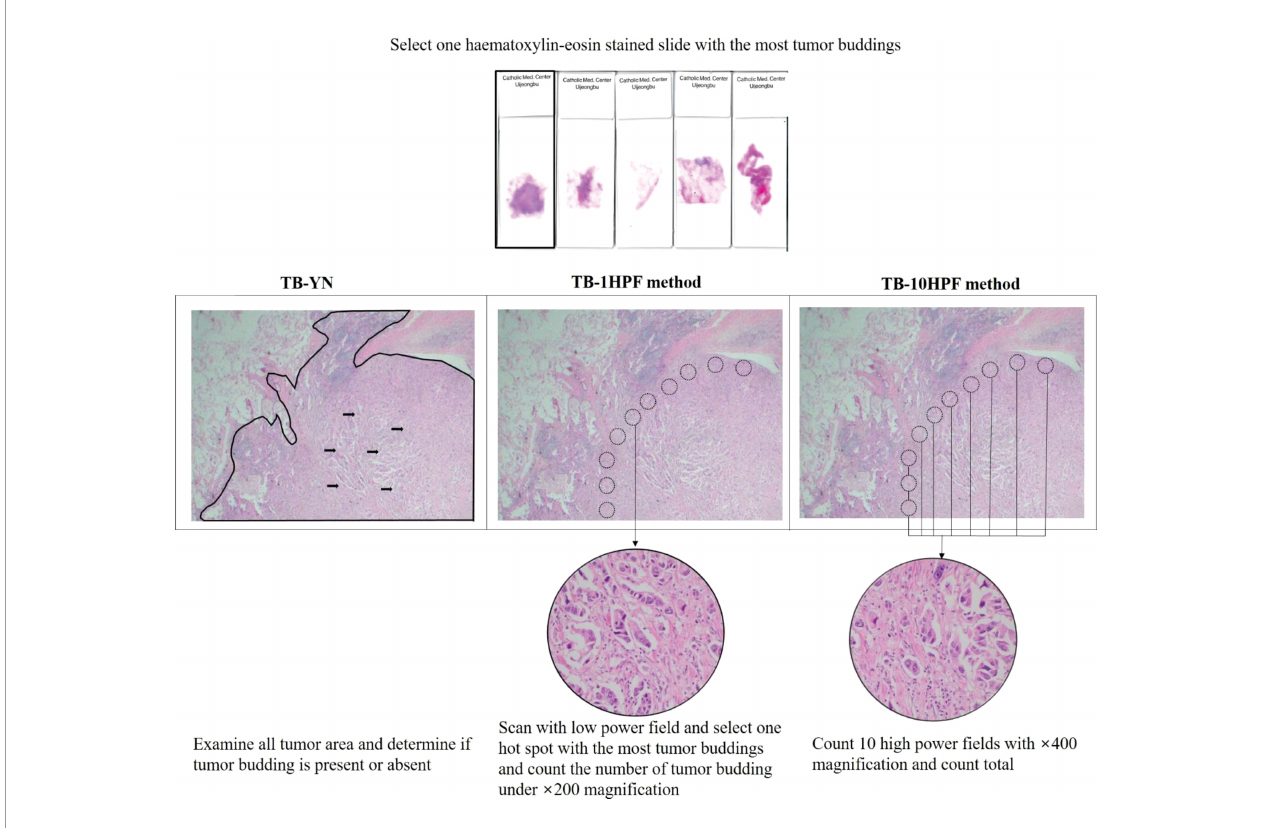
FIGURE 3 | Description of three representative tumor budding assessment